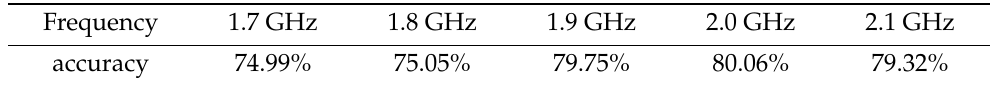
Figure 13. Recognition performance of Uni-LSTM sub-network on five frequencies, namely ( a ) 1.7 GHz, ( b ) 1.8 GHz, ( c ) 1.9 GHz, ( d ) 2.0 GHz, ( e ) 2.1 GHz. Table 2. The average accuracy of the LSTM network over 5